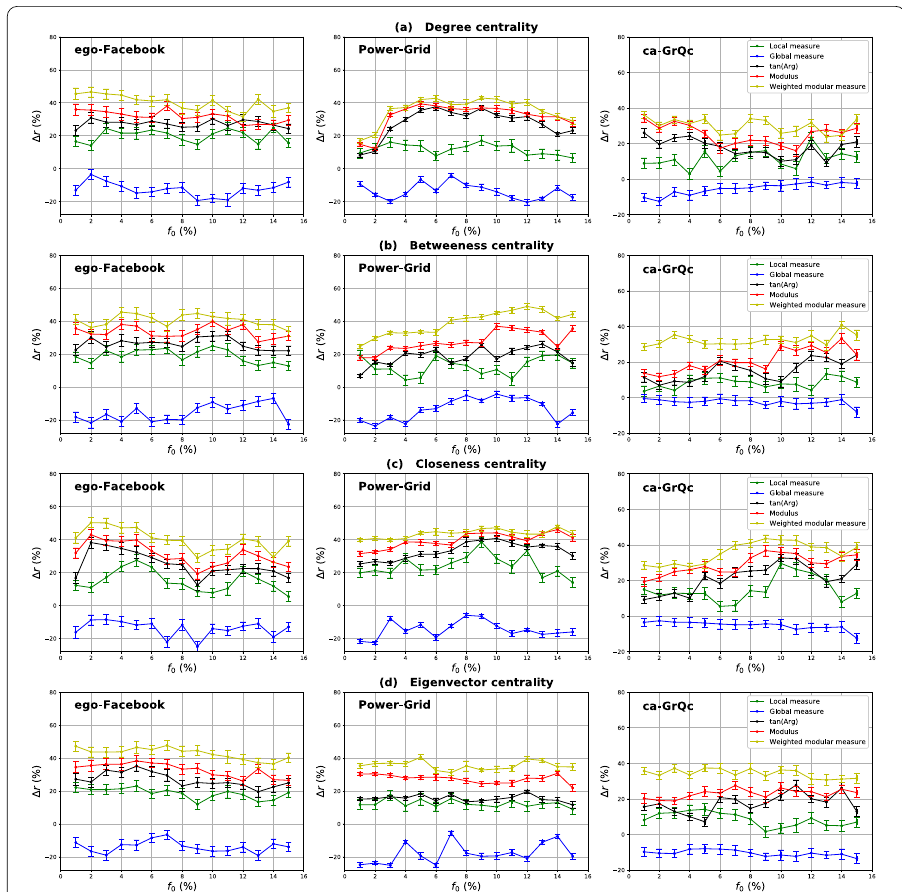
Figure 3 The relative difference of the outbreak size (cid:8) r as a function of the fraction of initial spreaders f 0 . The Degree ( a ), Betweenness ( b ), Closeness ( c ) and Eigenvector ( d ) centrality measures derived from the Modular centrality are compared to the standard counterpart designed for networks with no community structure. Real-world networks with strong community structure (ego-Facebook, Power-Grid and ca-GrQc networks) are used. The estimated values of their mixing coefficient is equal respectively to 0.03, 0.034 and